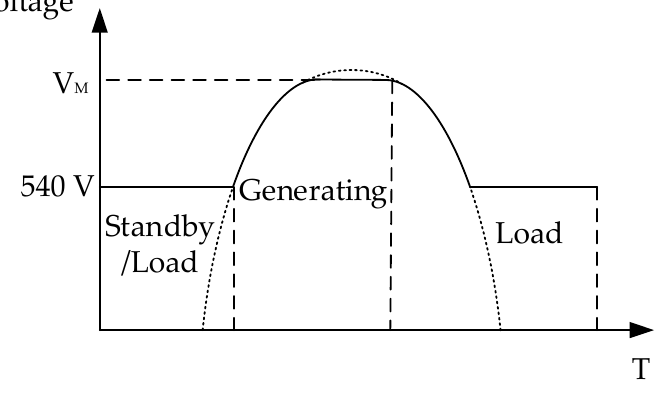
Figure 3. Voltage characteristics of the DC link in the elevator AC-DC-AC converter.